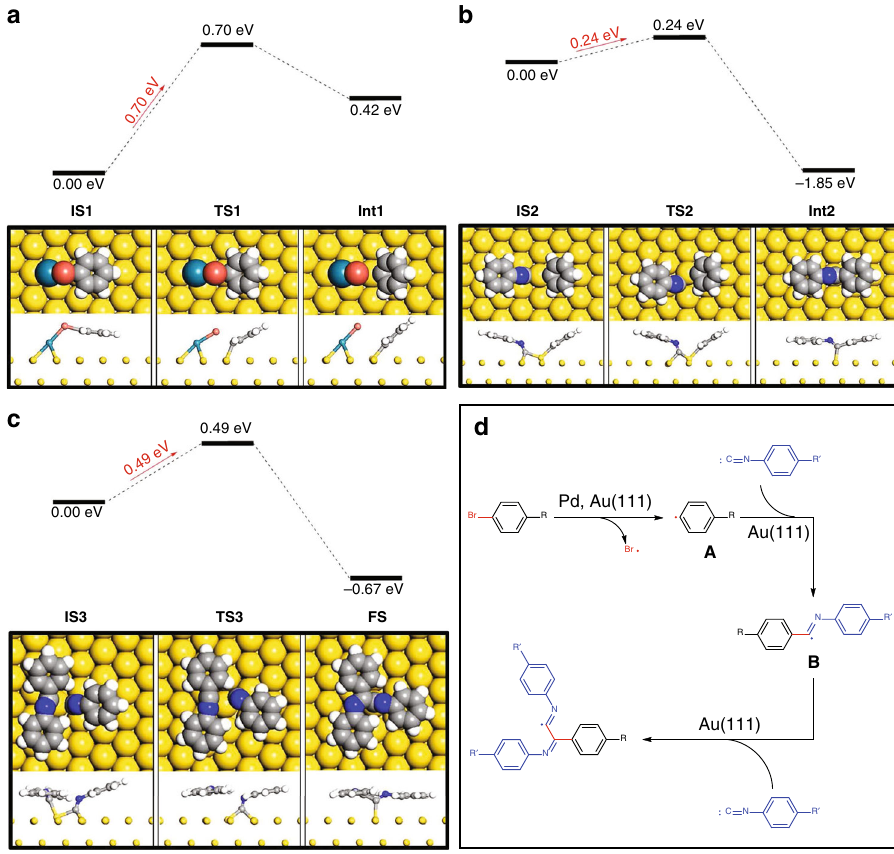
Fig. 4 Mechanism for the divergent cross-coupling of aryl bromide with isocyanide on Au(111). a – c DFT-calculated energy levels and molecular structures for a debromination of bromobenzene, b the fi rst addition of a benzene radical to isocyanobenzene, and c the second addition of an imidoyl radical to another isocyanobenzene. Top and side views of the initial state ( IS ), transition state ( TS ), intermediate state ( Int ), and fi nal state ( FS ) of the reactions are shown below the energy diagrams. d Overview of the reaction